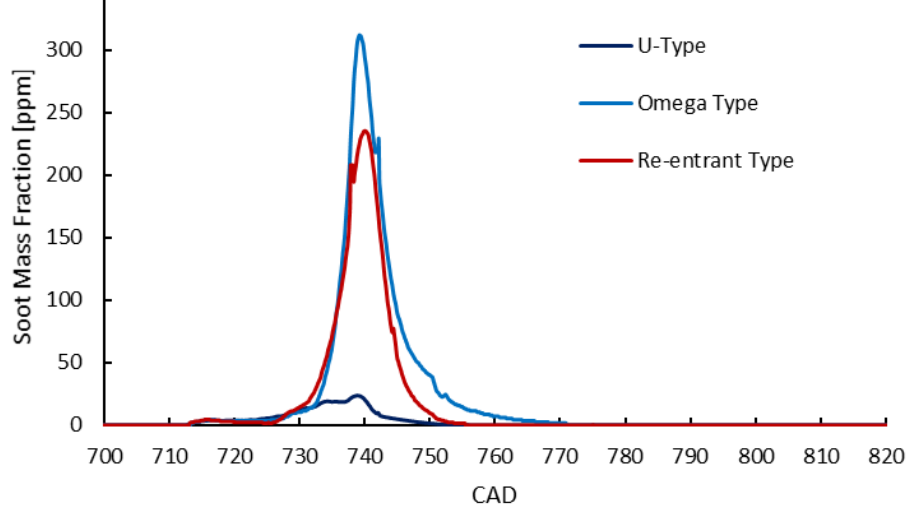
Figure 12. Soot emissions diagrams for the three various piston types.